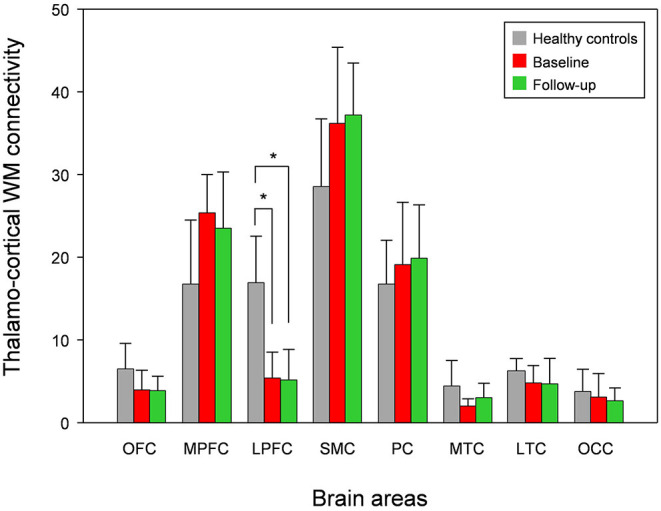
Mean white matter (WM) connectivity between the thalamus and each cortex in patients with MCI (baseline), donepezil-treated patients (Follow-up), and healthy controls. OFC, orbitofrontal cortex; MPFC, medial prefrontal cortex; LPFC, lateral prefrontal cortex; SMC, sensorimotor cortex; PC, parietal cortex; MTC, medial temporal cortex; LTC, lateral temporal cortex; OC, occipital cortex. *significant difference (Bonferroni corrected, p < 0.05).